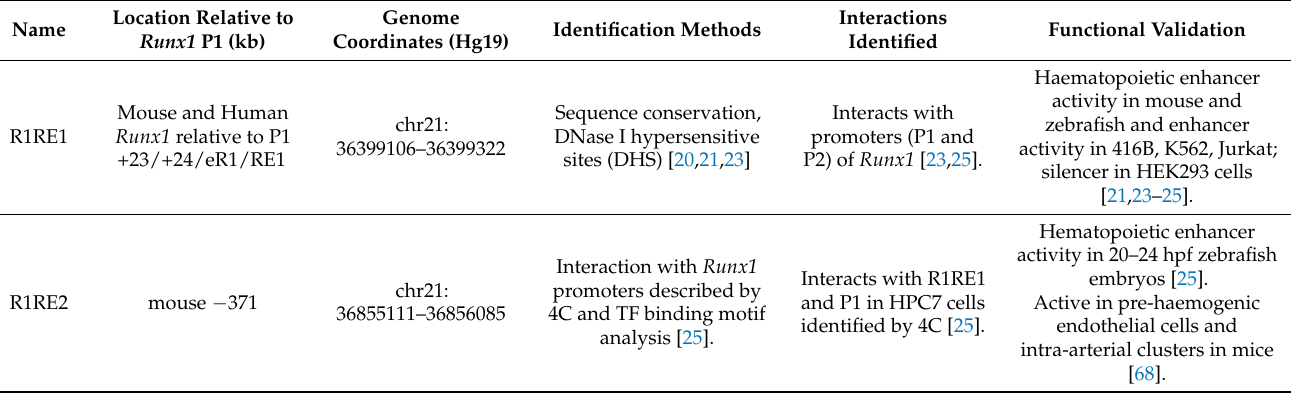
Table 1. Conserved mouse and human Runx1 regulatory